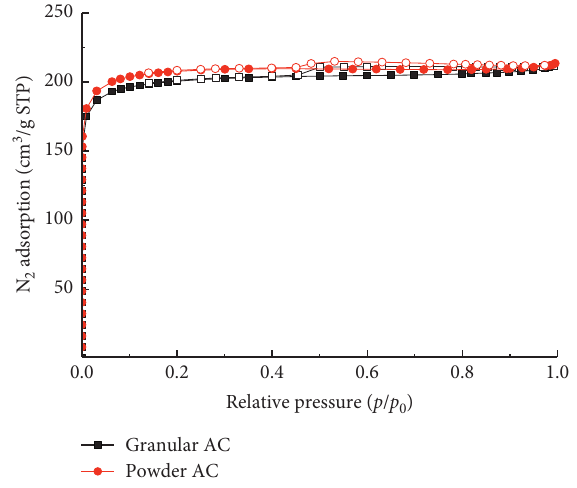
Figure 2: The N 2 adsorption isotherms of ACs. Table 1: The pore structure parameters of ACs.